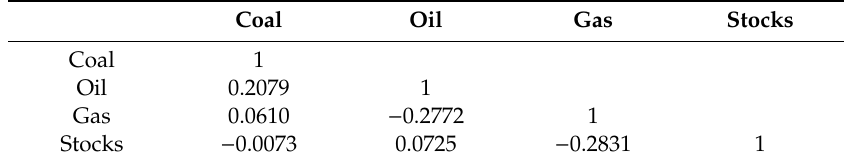
Table 11. Correlations for Denmark.